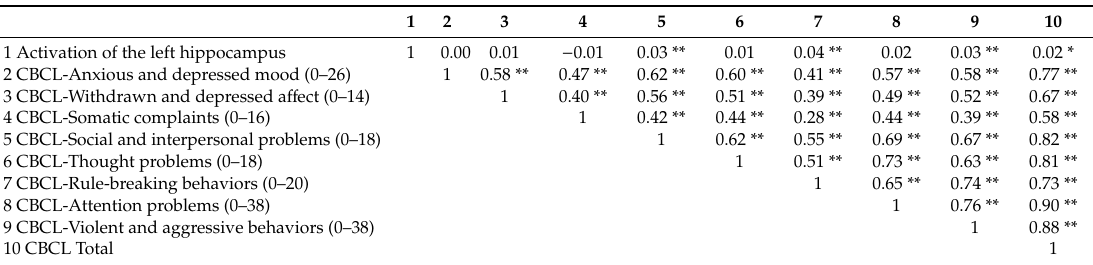
Table 4. Validation of the activation of the left hippocampus during an N-Back memory